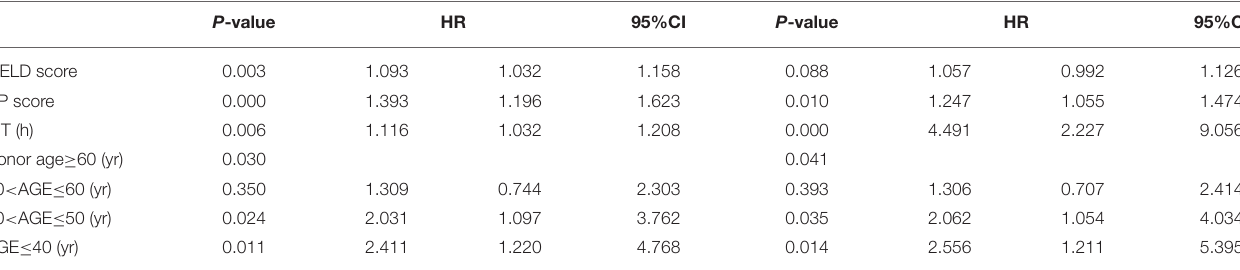
TABLE 3 | Univariate and multivariate logistic analysis of risk factors associated with length of intensive care unit stay over 10 days. P -value HR 95%CI P